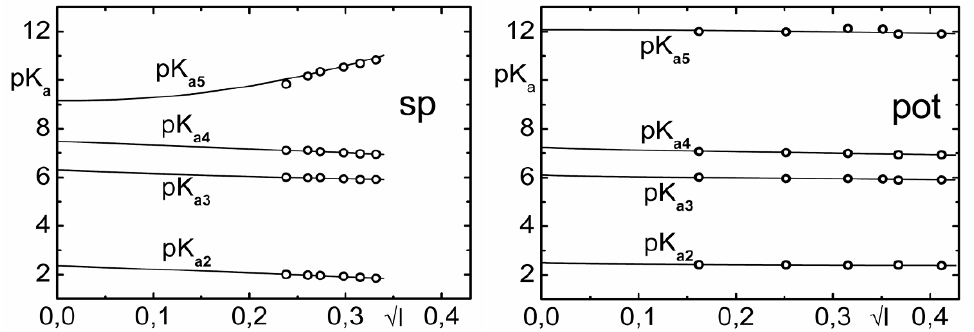
of risedronate estimated spectrophotometrically (sp) and a,i = 9.31(7) and 8.70(3) at 25ºC and 37ºC. a,5